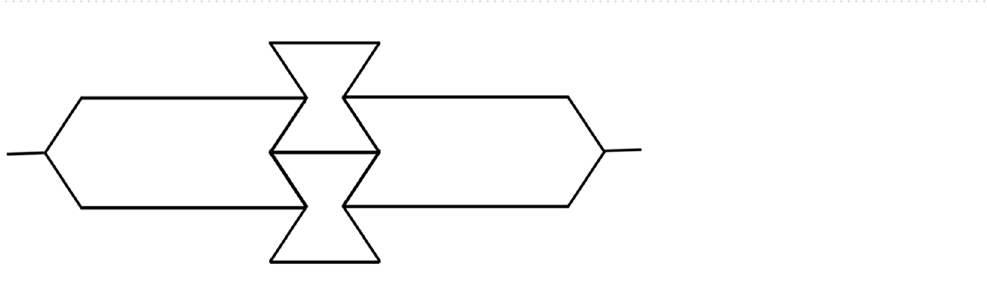
Figure 4. Auxetic